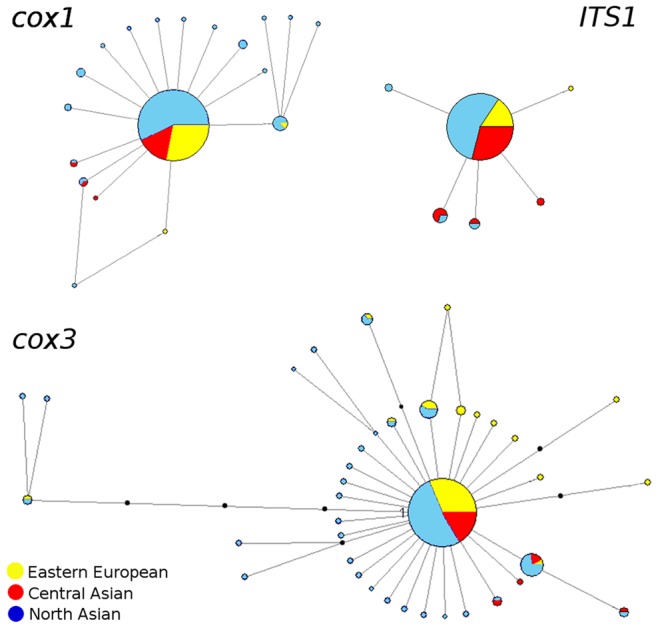
The statistical parsimony networks of cox1, ITS1 and cox3 haplotypes.The sizes of haplotypes are proportional to the number of samples. Small black circles indicate un-sampled or extinct haplotypes.